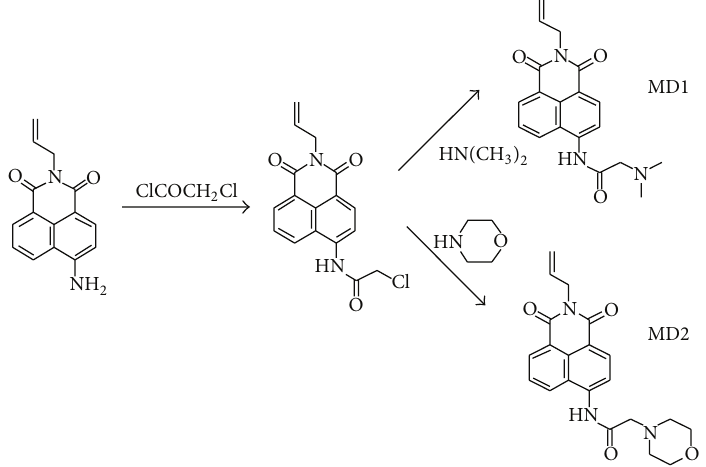
Scheme 1: Synthesis of monomeric MD1 and